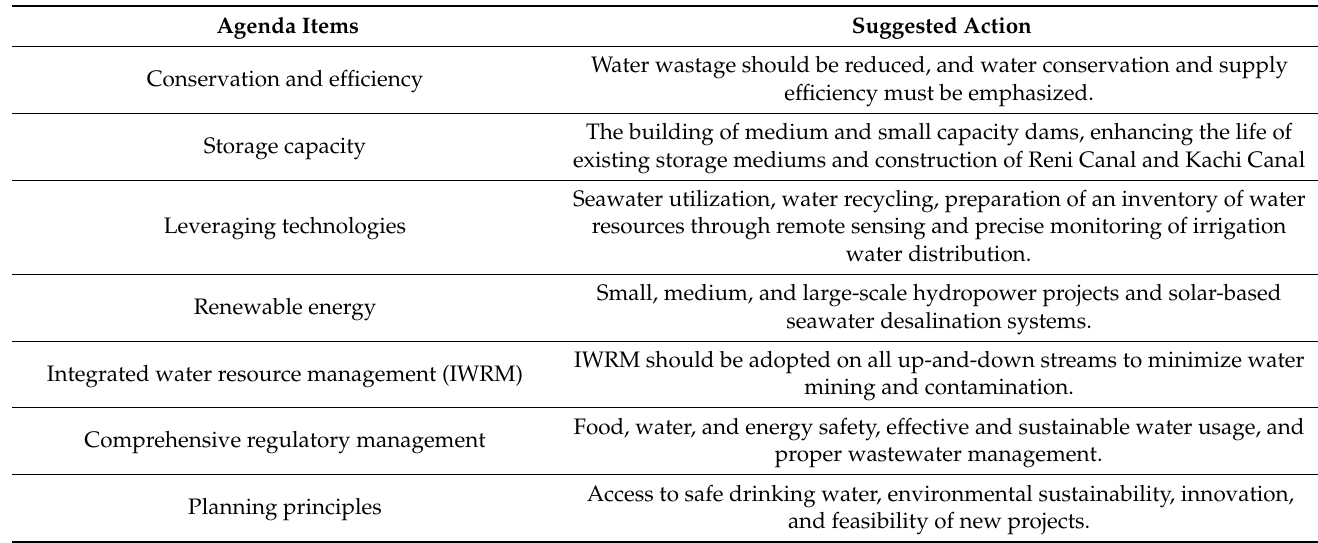
Table A1. National water policy of Pakistan, agenda items and suggested actions [64,65]. Agenda Items Conservation and